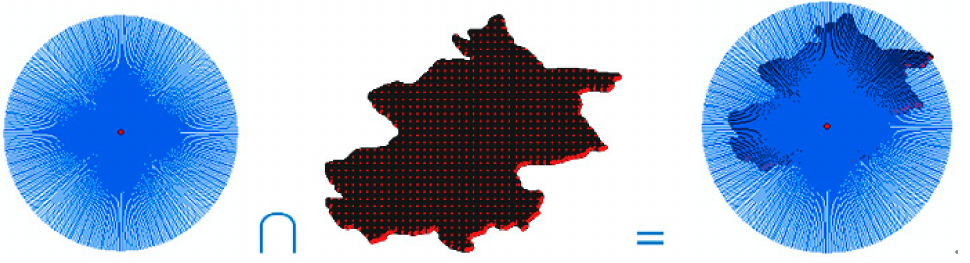
Figure 6. Schematic diagram of the data columns derived in 360 directions. (The center of the circle is blurred because the 360 lines are too